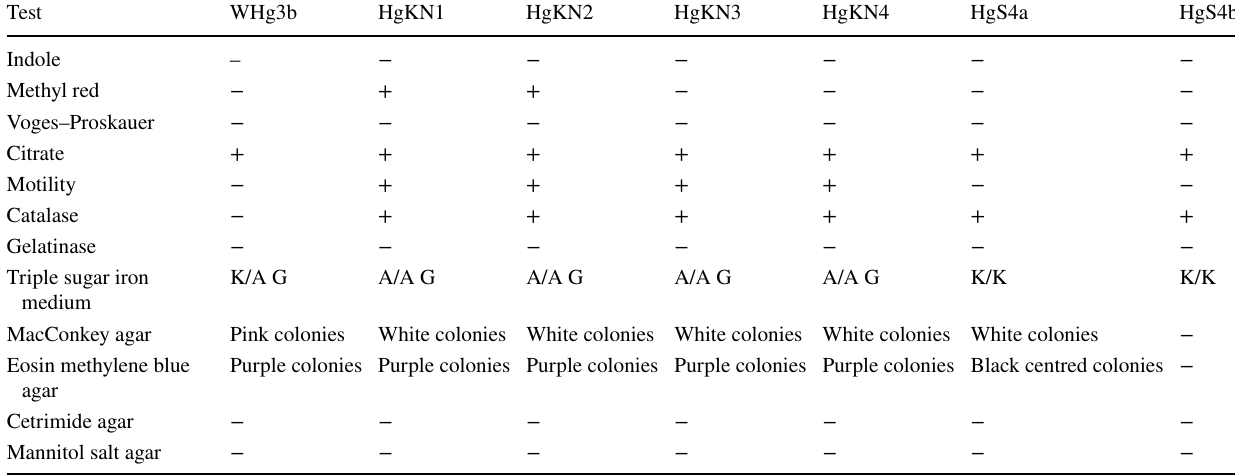
Table 4 Biochemical characteristics of the isolated mercury-resistant bacteria